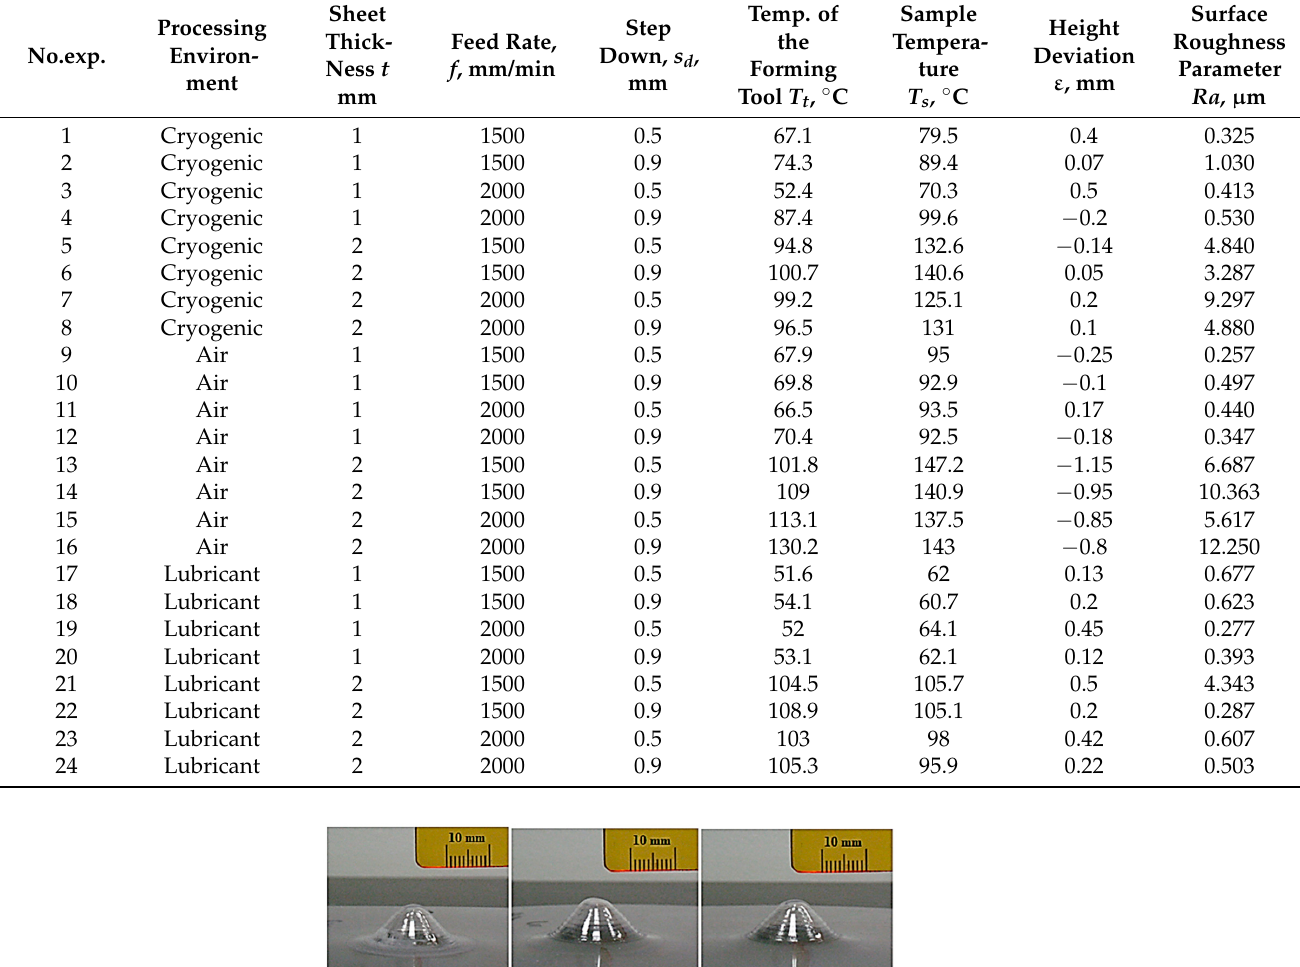
Table 2. Experimental conditions and results.